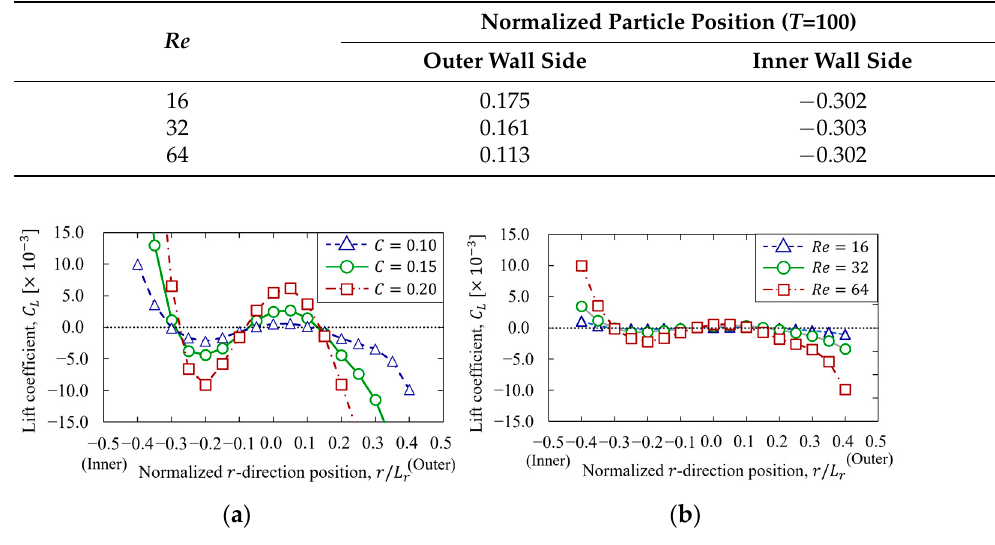
Figure 13. Inertial lift force acting on the particle at each 𝑟 -direction position. ( a ) confinement 𝐶 dependence. ( b ) Reynolds number 𝑅𝑒 dependence.